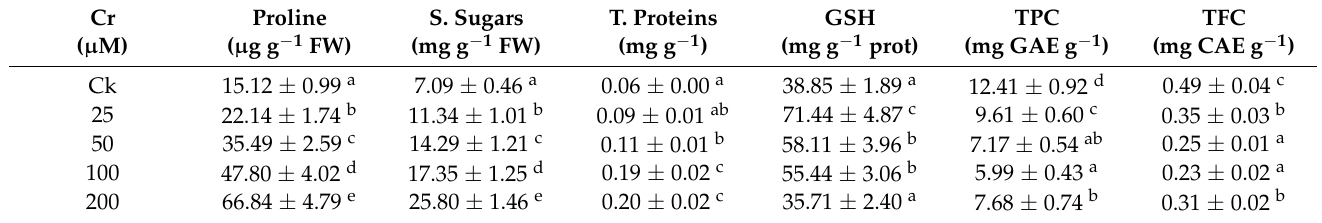
Figure 6. Impact of Cr on the production of hydrogen peroxide and MDA in the leaves of sweet potato. Means followed by different letters indicate a significant difference ( p < 0.05) among the five treatments according to the Tuckey test. Error bars show mean ± SE. Table 4. Impact of Cr on the production of osmolytes and antioxidants in the leaves of sweet